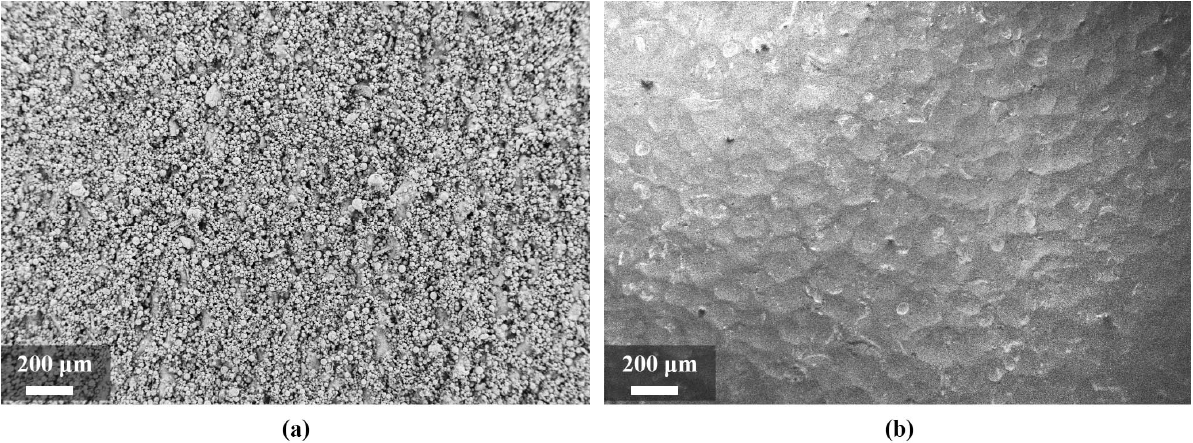
Figure 8. FESEM images of the surface roughness on the lateral surface of the sample 6 before ( a ) and after ( b ) shot blasting with glass beads.